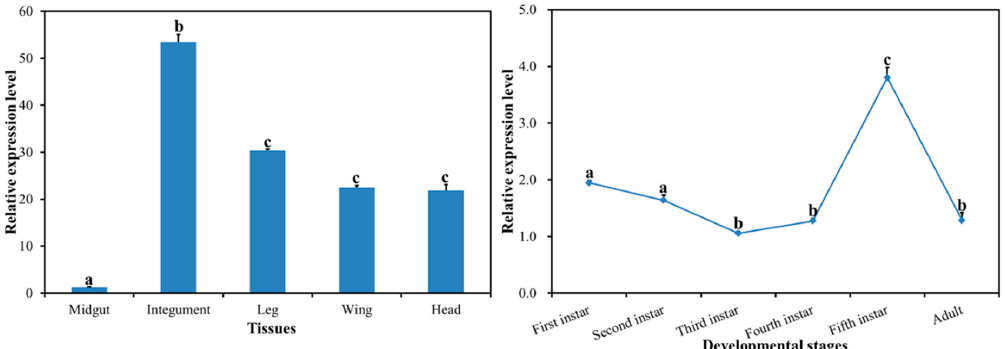
(Ms), Plutella xylostella (Px), Spodoptera exigua (Se), Tribolium castaneum (Tc), Ostrinia furnacalis (Of), Spodoptera frugiperda (Sf), Anasa tristis (At), and Bactrocera dorsalis (Bd). Int. J. Mol. Sci. 2019 , 20 , x FOR PEER REVIEW